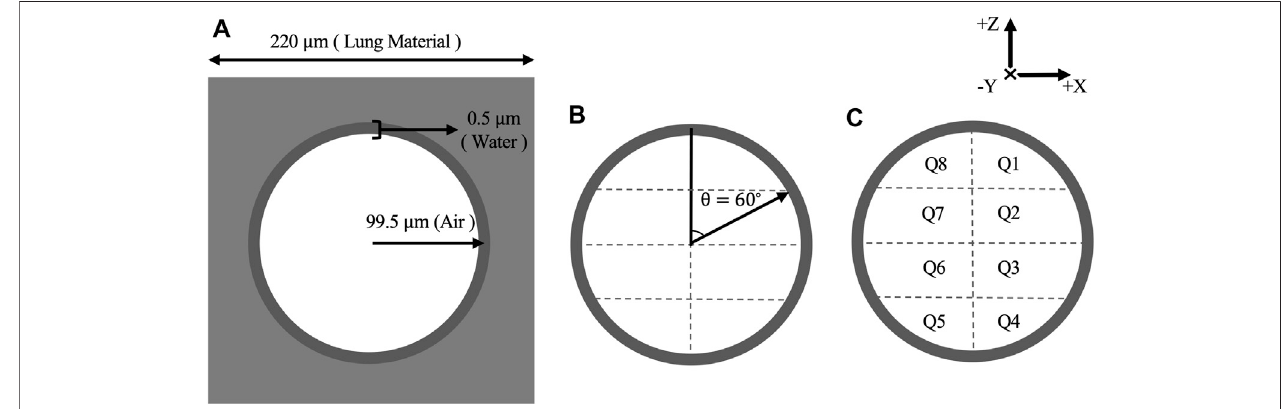
FIGURE1|(A) Schematicdiagramofalveolusmodelwithcorrespondingmeasurements(nottoscale)andmaterials. (B) Watershelldividedinto16quadrantswith equal volume by setting θ (cid:1) 60 + from the zenith point. (C) Quadrant labels for retracing energy deposition (only the front “ A ” quadrants are shown; “ B ” quadrants are on the reverse